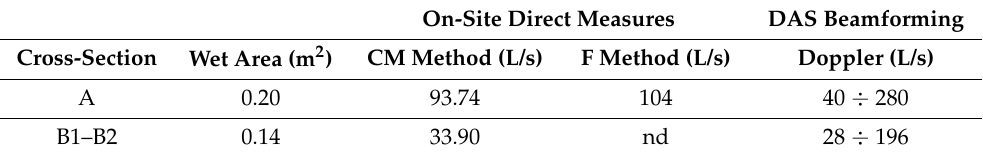
Table 1. Values of the transit flow rate (Q) measured in the cross-sections (nd = not determined).